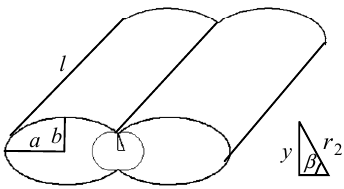
N2 A Figure 6. SRVF-LB model schematic. Similarly to Equation (28), SRVF-LB can be expressed as: